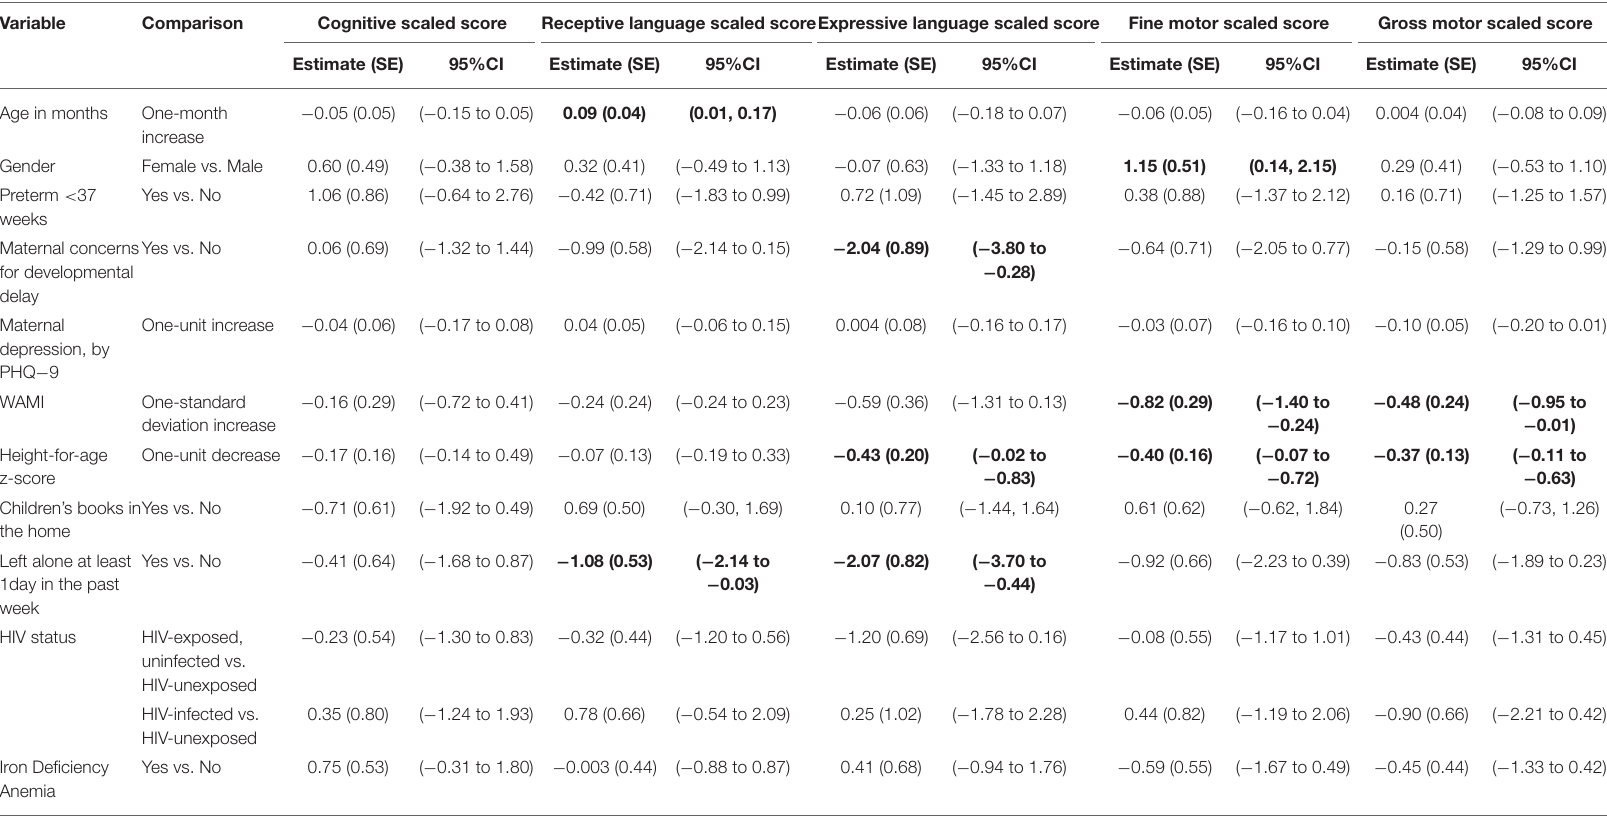
TABLE 3 | Adjusted linear regression analysis of study population, aged 18–36 months, by Bayley-3 subtest.